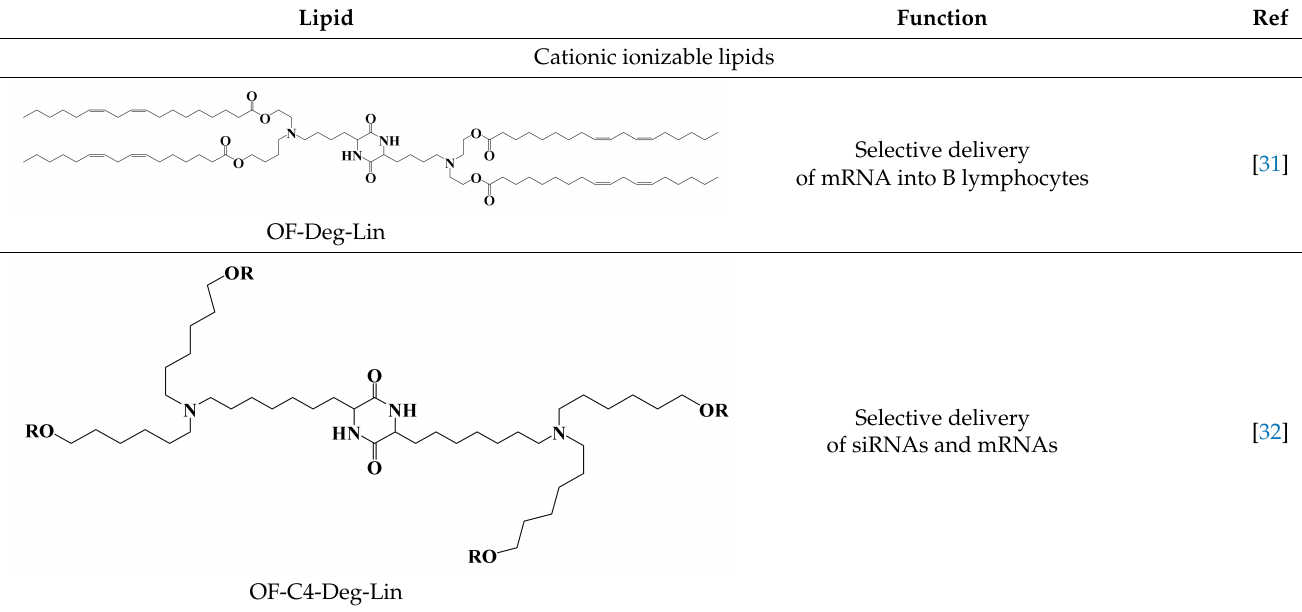
Table 1. Shows the chemical structures of different lipids used in LNPs for mRNA delivery.